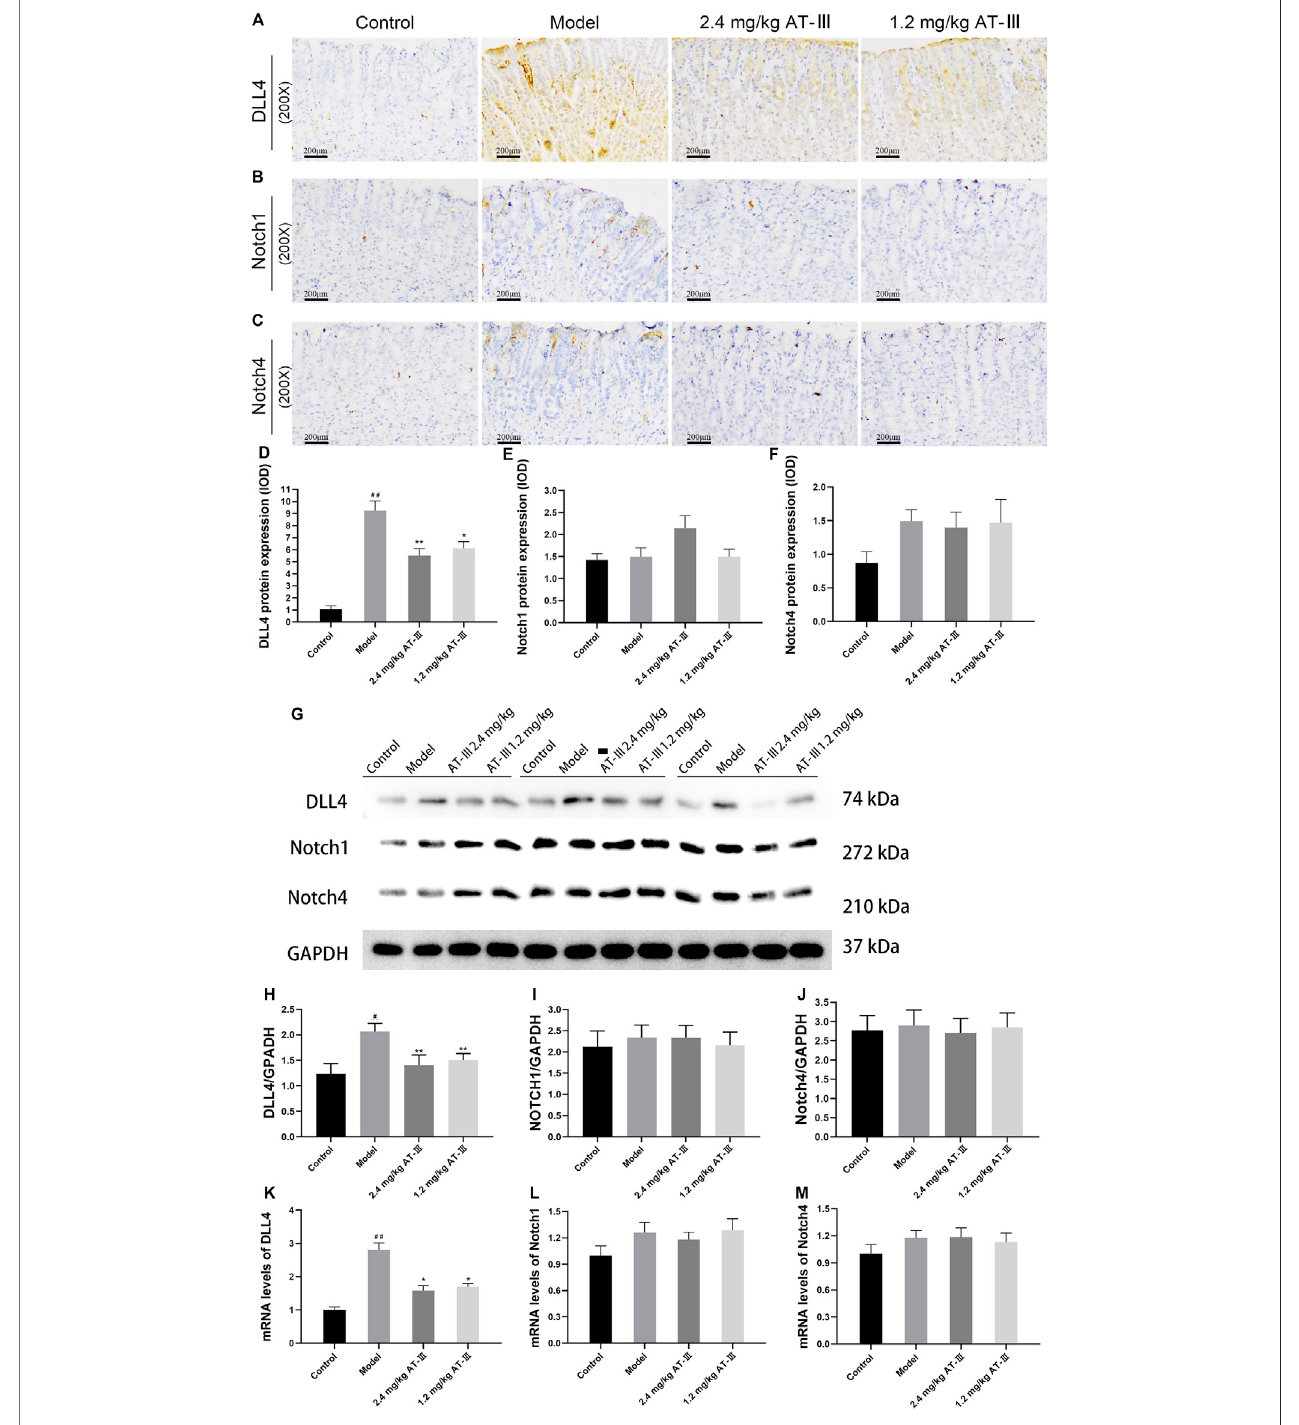
FIGURE 5 | The rat samples were detected by IHC. Expression of DLL4 (A) , Notch1 (B) and Notch4 (C) in gastric mucosa from various groups. Semi-quantitative analysisofDLL4 (D) ,Notch1 (E) andNotch4 (F) protein expressionlevelsineach group( n =10). (G) Representativeimagesofwesternblotproteinsbands. Quantitative analysisofDLL4 (H) ,Notch1 (I) andNotch4 (J) inwesternblottingbands( n =9).QuantizationformRNAlevelsofDLL4 (K) ,Notch1 (L) andNotch4 (M) ingastricmucosa from various groups ( n = 6). (J) Representative western blotting bands of DLL4, Notch1 and Notch4. # p < 0.05, ## p < 0.01 versus the control group; * p < 0.05, ** p < 0.01 versus the model group. Data are presented as mean ± SEM. AT-III, Atractylenolide III; IHC, immunohistochemistry; SEM, standard error of mean.